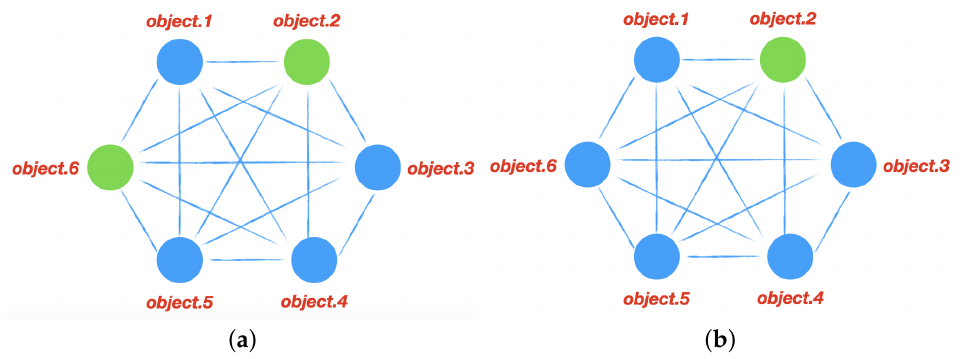
Figure 3. Schemes representing a combinatorial problem of a pairing, given N = 6 objects; the collection is made by the true pair (green elements) and from other objects (blue elements). If the true pair of objects is present in collection the efficiency of tagging will depend only on the accuracy of the algorithm ( a ); otherwise, the efficiency will be even lower if one object is not present in the collection at all ( b